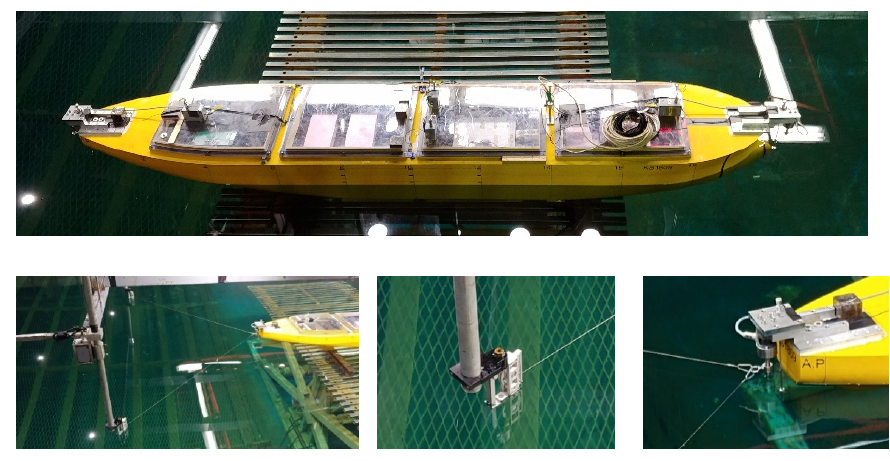
Figure 3. Configuration of model